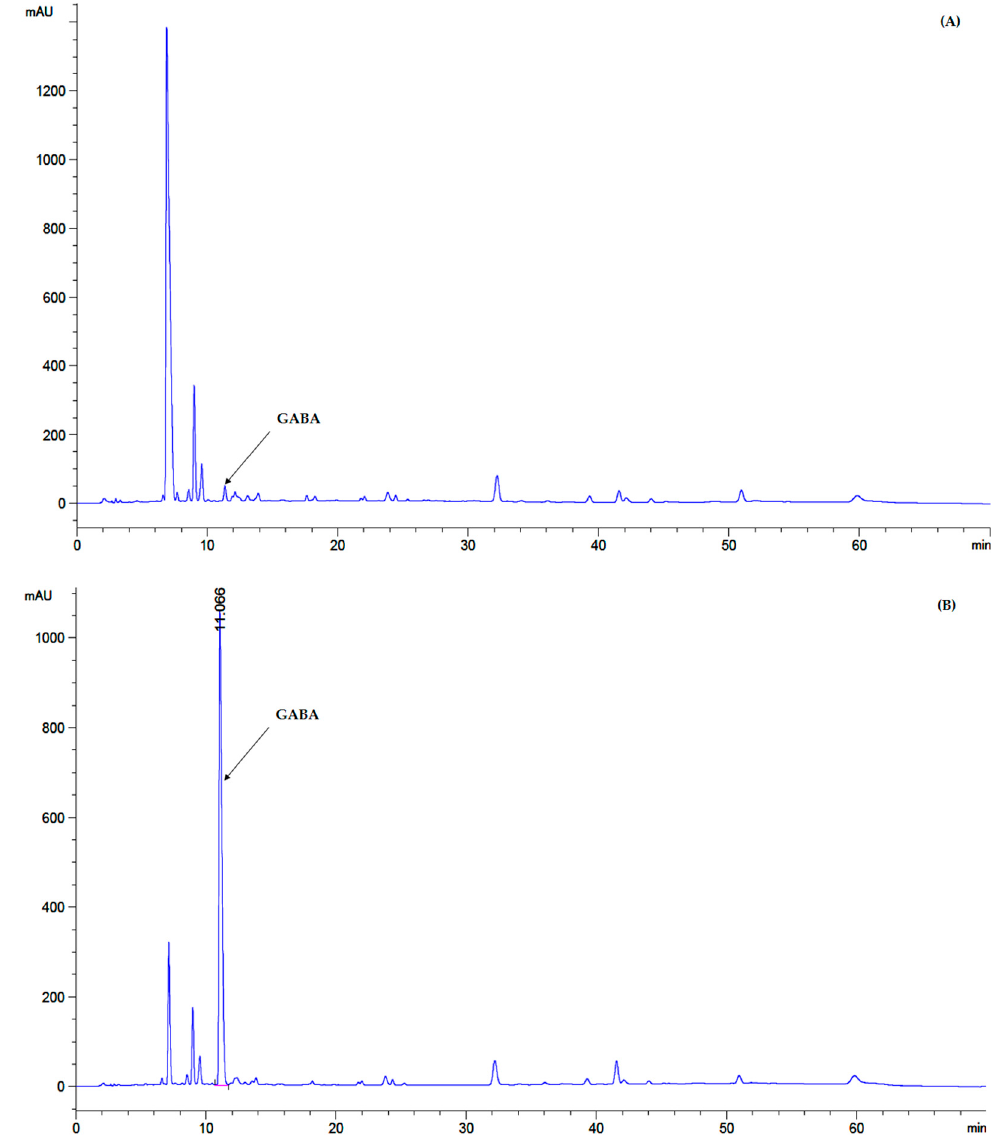
Figure 7. Chromatogram of GABA analysis of GABA-FMJ at 0 h ( A ) and 48 h ( B ) of incubation.